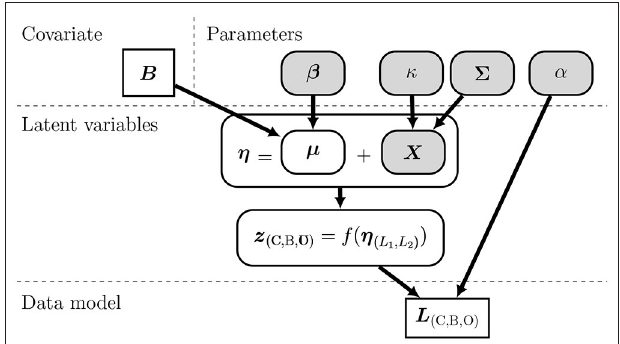
FIGURE 1 | Hierarchical graph describing the conditional dependencies between observations (white rectangle) and parameters (gray rounded rectangles) to be estimated. The white rounded rectangles are computed based on the estimations. In a generalized linear mixed model framework, η is the linear predictor—consisting of a regression term, µ , and a spatial random effect, X . The link function, f ( η ), transforms between linear predictor and proportions, which are matched to the observed land cover proportions, L (C,B,O) , using a Dirichlet